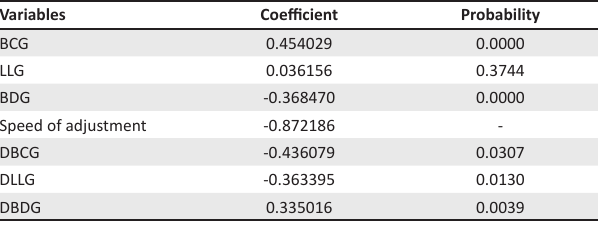
TABLE 5: Autoregressive distributive lag test results, 1980–2014. Variables Coefficient